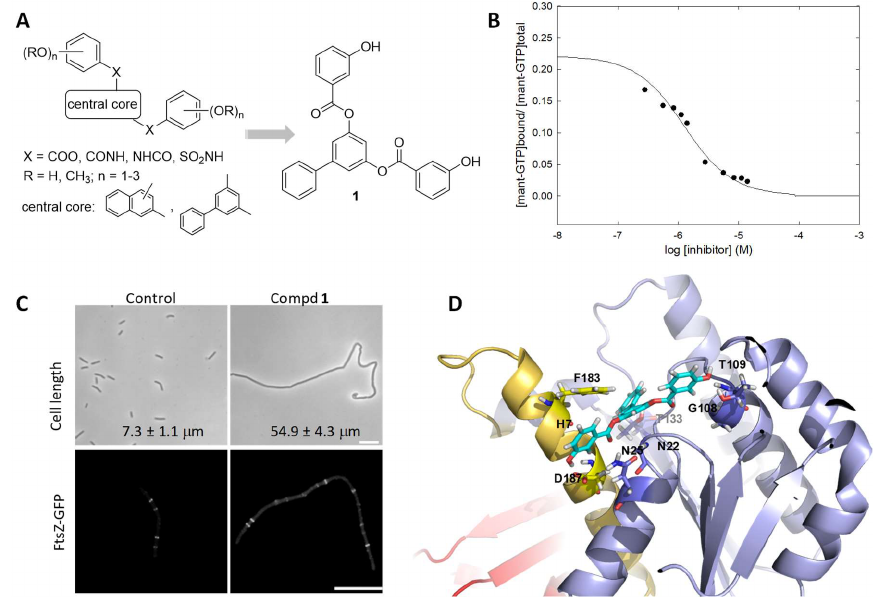
Figure 2. ( A ) General chemical structure of polyhydroxy aromatic GTP-replacing inhibitors and of the identified inhibitor 1 [55,56]. ( B ) Displacement of mant -GTP (1 µ M) from BsFtsZ (0.9 µ M binding sites) by compound 1 , measured by fluorescence anisotropy. The line is the least squares best-fitted competition curve ( K D = 0.5 µ M). ( C ) Upper panel, cells of B. subtilis 168 treated with 1 (4 µ M) for 3 h and observed by phase-contrast microscopy. Mean and standard error of cell length measurements are indicated. Lower panel, cellular localization of FtsZ-GFP in B. subtilis SU570 following growth for 1.5 h in the absence and presence of 1 (3 µ M). Scale bars: 10 µ m. ( D ) BsFtsZ- 1 model complex from docking and MD simulations. The ligand is shown in sticks represented with cyan carbon atoms. The amino acid residues that interact with the inhibitor and are shared key residues for nucleotide binding in the BsFtsZ-GDP complex [PBD 2RHL, [56]] are indicated and displayed in sticks. (( B – D ) adapted with permission from [56]; copyright 2015 American Chemical